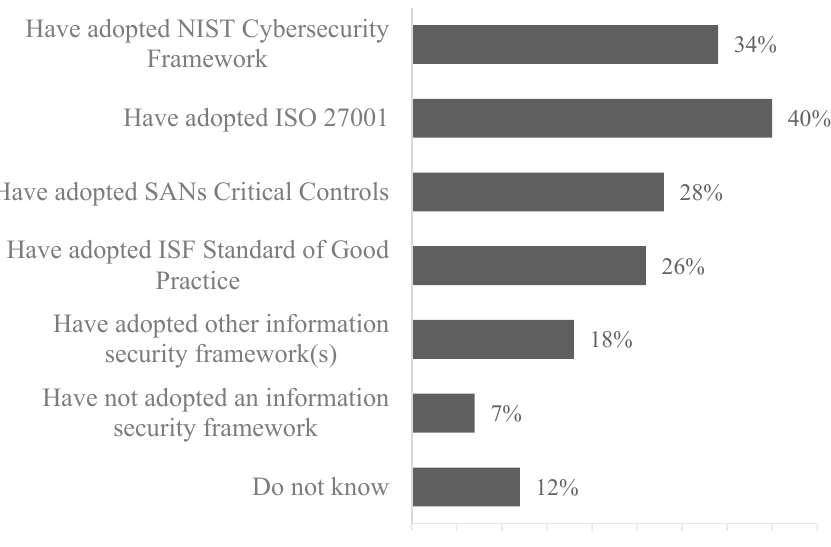
Figure 4. Data from PwC’s “The Global State of Information Security ® Survey 2016”.